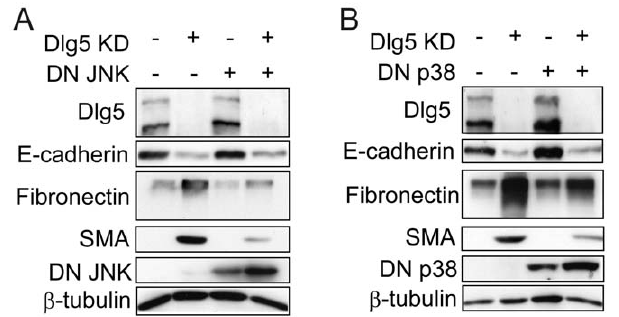
Figure 5. Dominant-negative mutants of JNK and p38 suppress the expression of mesenchymal marker proteins in Dlg5- depleted cells. A: Six hours after transfection of a dominant-negative JNK mutant or a control plasmid into LLc-PK1 cells, the cells were further transfected with control or Dlg5 siRNA. After incubation for two days, expression of the indicated proteins was investigated by immunoblotting. B: Dominant-negative p38 mutant or a control plasmid was transfected into LLc-PK1 cells and treated and analyzed as in A. Expression of b -tubulin was detected as a loading control. The results are representative of at least three independent experiments. The expression levels of dominant-negative mutants were affected by Dlg5 knockdown by an unknown mechanism. Dominant-negative mutants of JNK and p38 suppressed the expression of fibronectin and SMA.